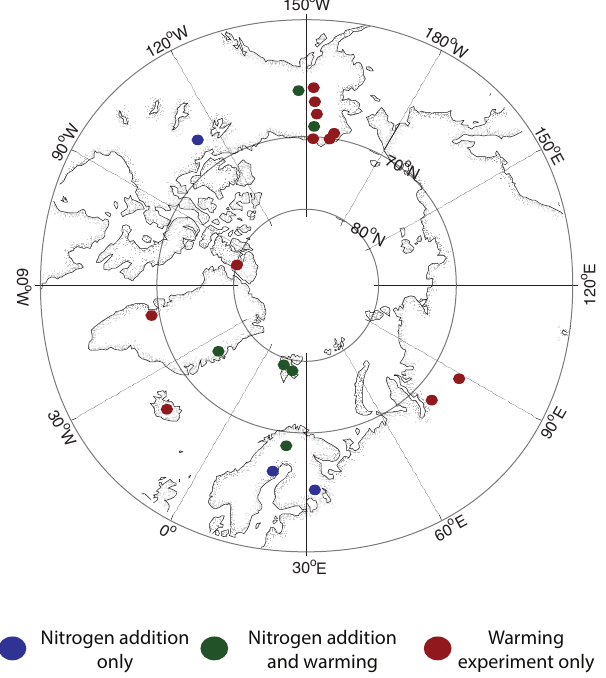
Figure 1. Study sites included in the